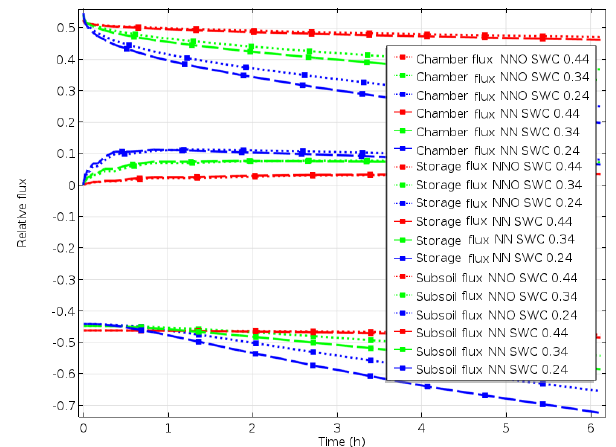
Figure 4. Relative fluxes following chamber closing with differ- ent water contents in scenario A_bottom_open (surface flux, stor- age flux and subsoil flux starting at positive values, at zero and at negative values,